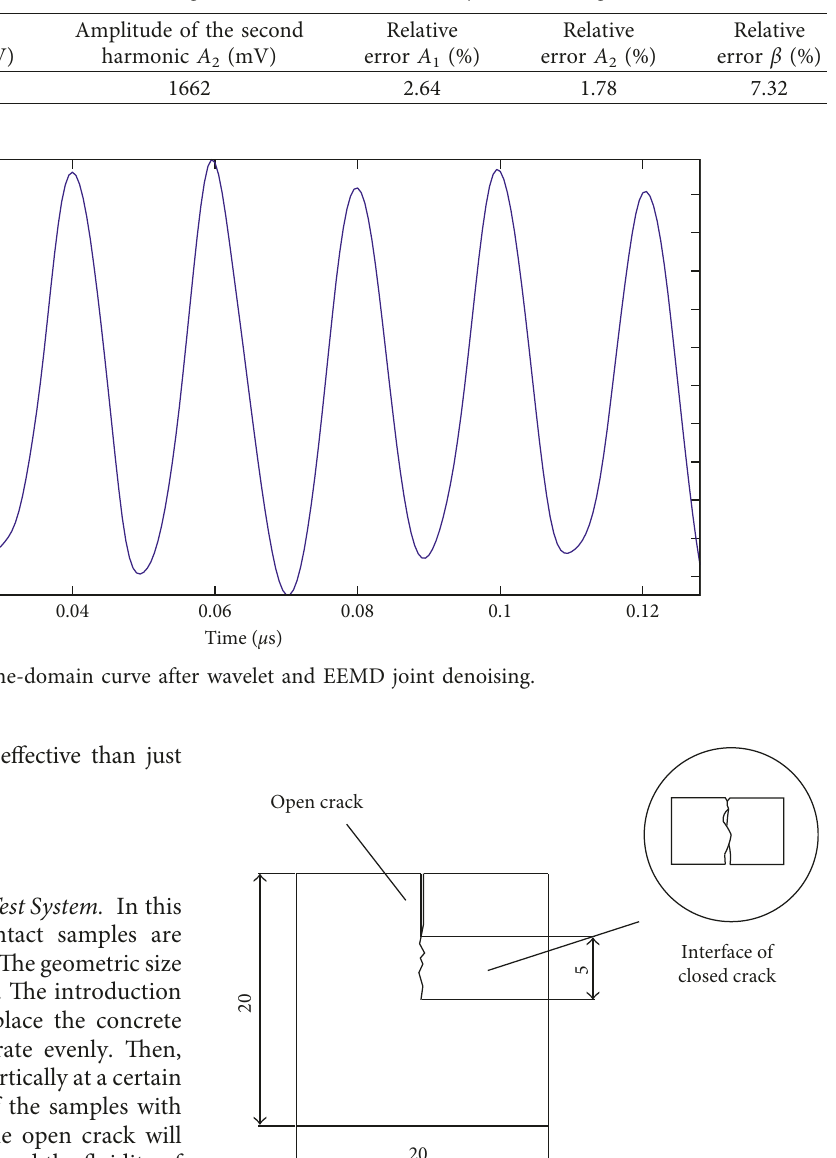
Table 3: Characteristic indicators of the signal after wavelet and EEMD joint denoising.